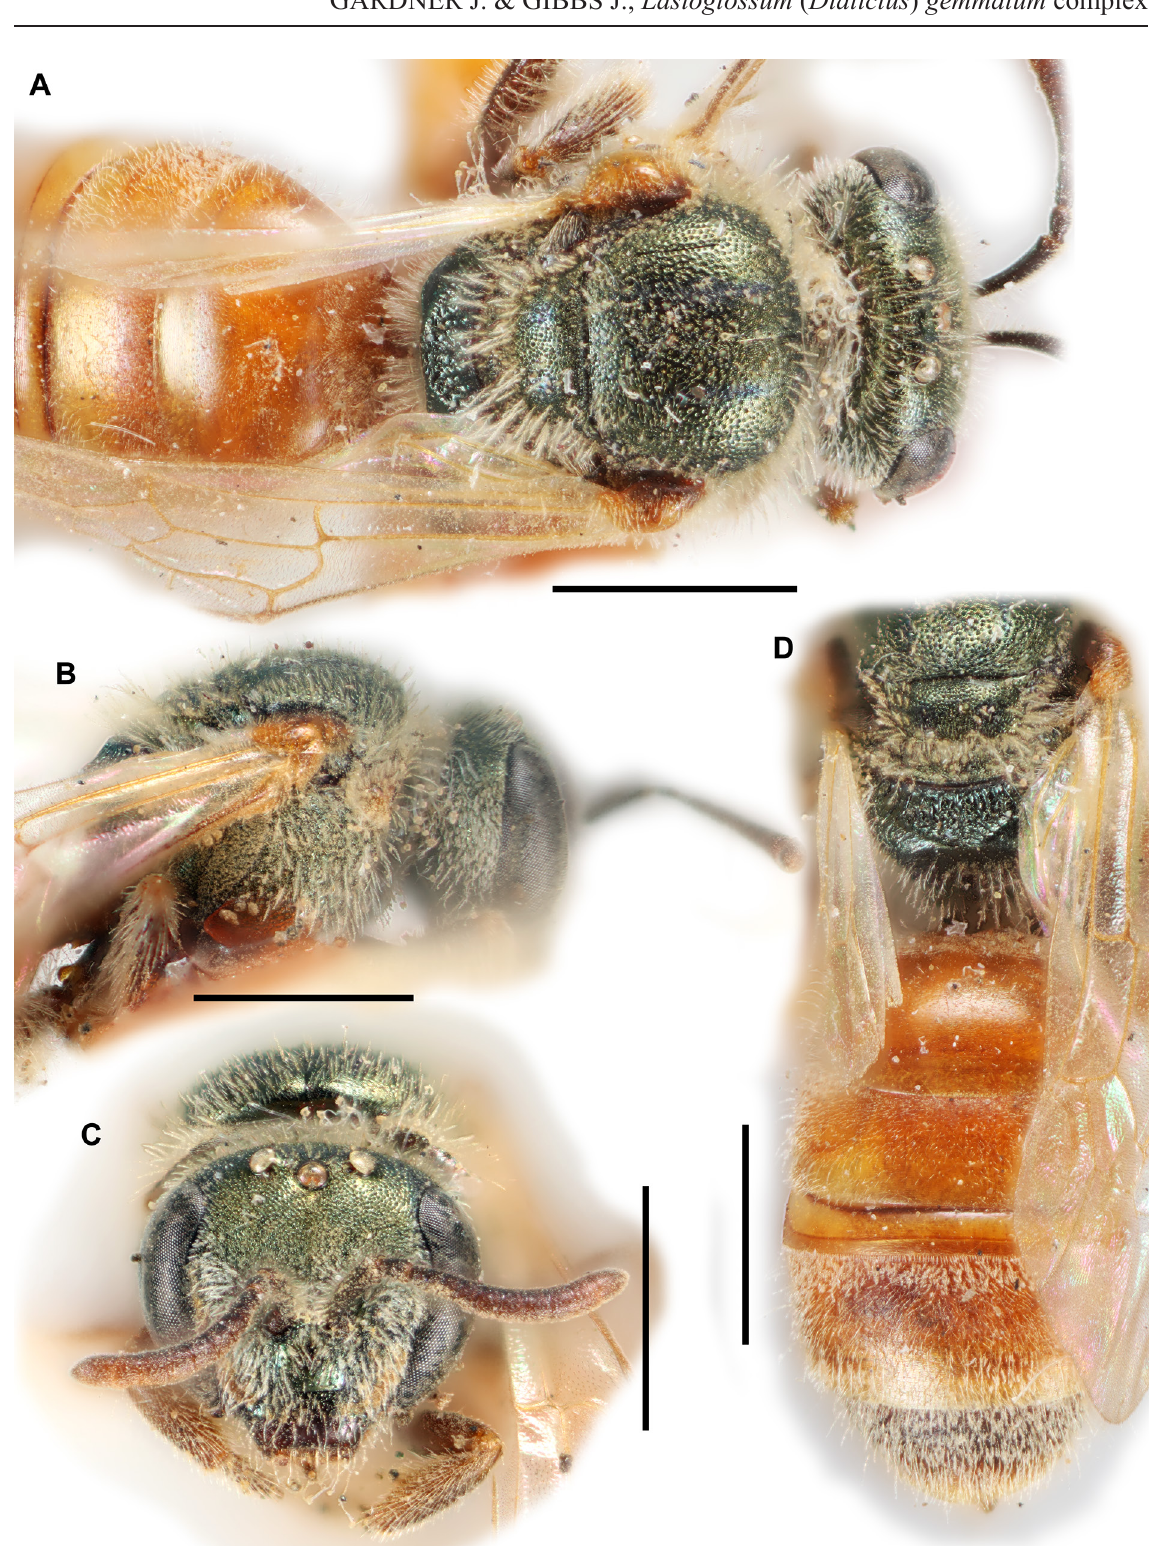
Fig. 18. Lasioglossum ( D .) ellisiae (Sandhouse, 1924), ♀, holotype of L . ( D .) hunteri (Crawford, 1932) (USNM). A . Mesonotum. B . Mesepisternum. C . Face. D . Metasoma and propodeum. Scale bars = 1